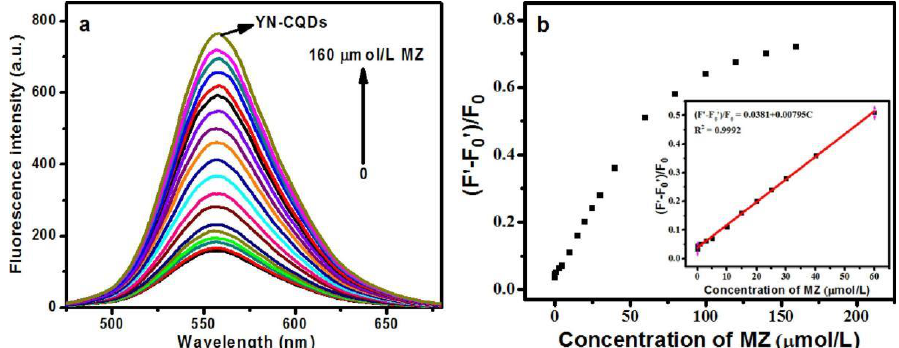
Figure 10. Schematic illustration of ( a ) fluorescence emission spectra of the YN-CQDs/Ag + system upon addition of various concentrations of MZ. ( b ) relationship between recovery efficiency and the concentration of MZ. Inset: a linear relationship of recovery efficiency versus the concentration of MZ over the range from 0.003 to 60 μ M. Adapted with permission from Yu et al., 2021, Copyright 2021. Reproduced with permission from Elsevier [70].